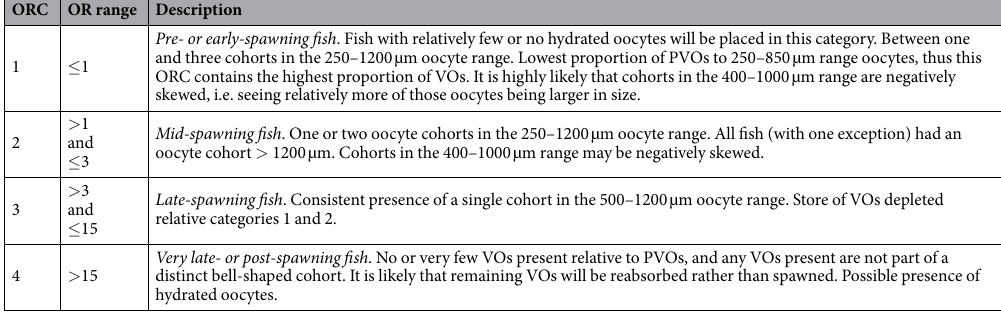
Table 1. Details for each oocyte ratio category (ORC), including oocyte ratio (OR) range and oocyte size frequency distribution (OSFD) characteristics. Representative OSFDs for each ORC are presented in Fig. 2.